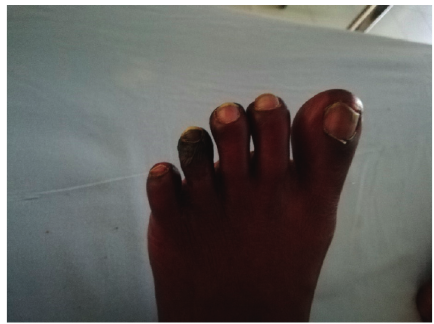
Figure 2: Dry gangrene of the left 4th toe.